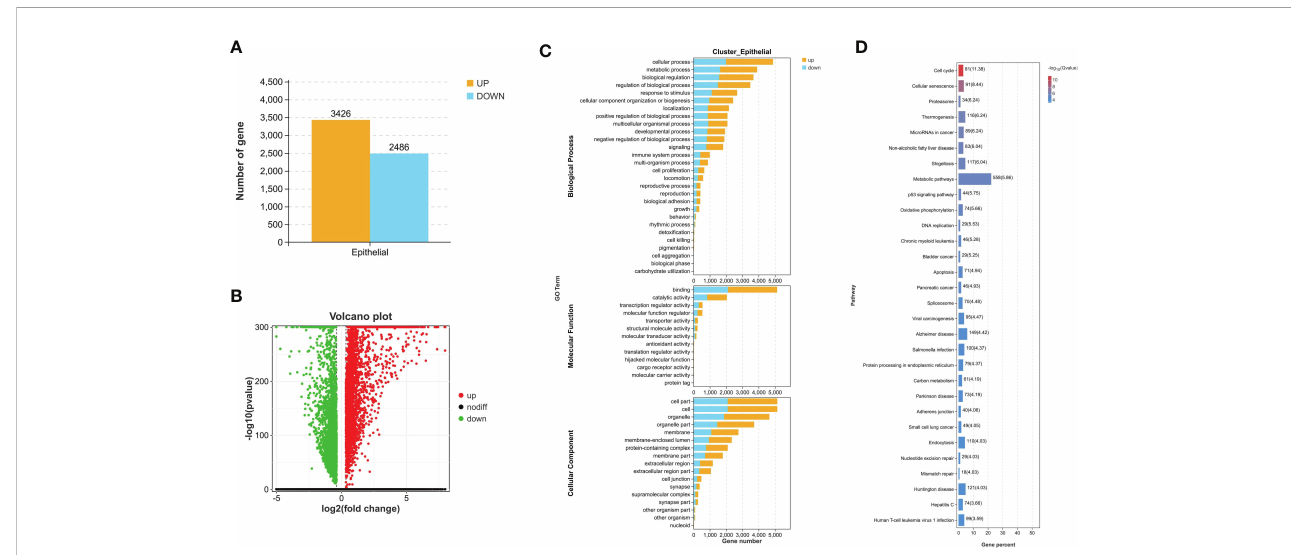
FIGURE 3 Difference comparison between MIBC and NMIBC. (A) The number of upregulated DEGs and downregulated DEGs between MIBC and NMIBC. (B) The volcano plot of DEGs. (C) Enriched GO functions of DEGs in malignant epithelial cells. (D) Highly enriched KEGG pathway of DEGs in malignant epithelial cells. MIBC, muscle-invasive bladder cancer; NMIBC, non-muscle-invasive bladder cancer; DEGs, differentially expressed genes; GO, Gene Ontology; KEGG, Kyoto Encyclopedia of Genes and Genomes.